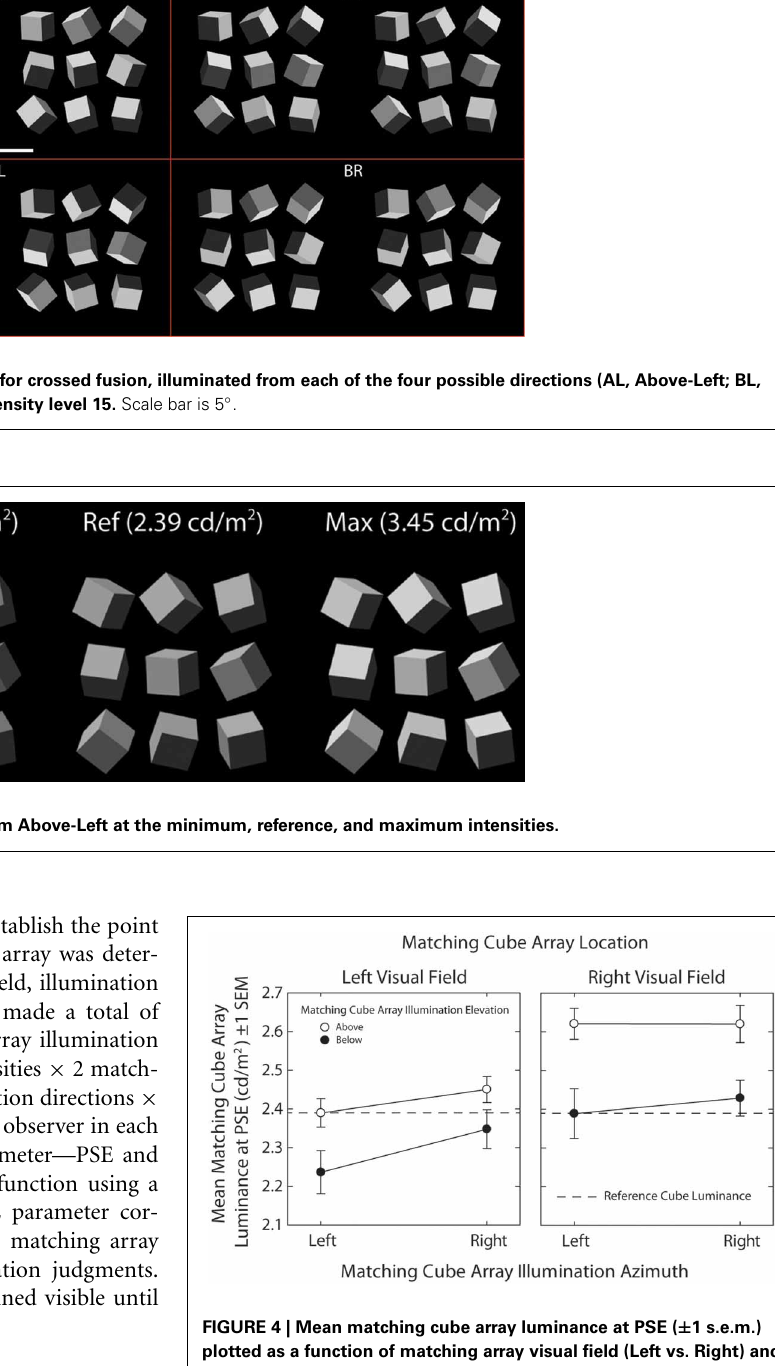
Above vs. Below) × 2 (Illumination Azimuth: Left vs.